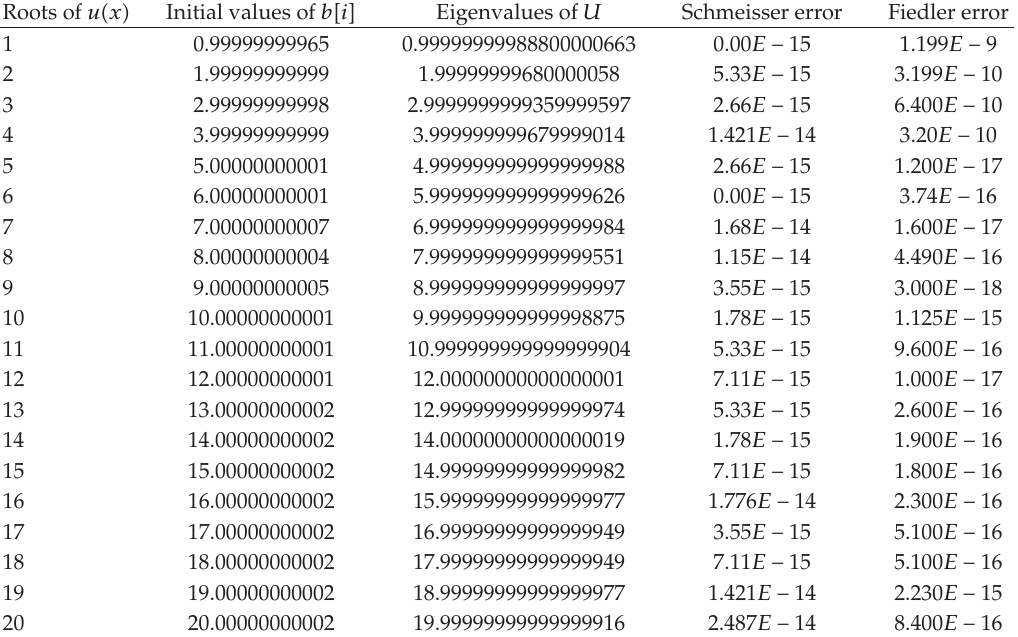
Table 1: Achieved roots of Wilkinson polynomial by considering initial values of Schmeisser’s method. Roots of u (cid:5) x (cid:6) Initial values of b (cid:3) i